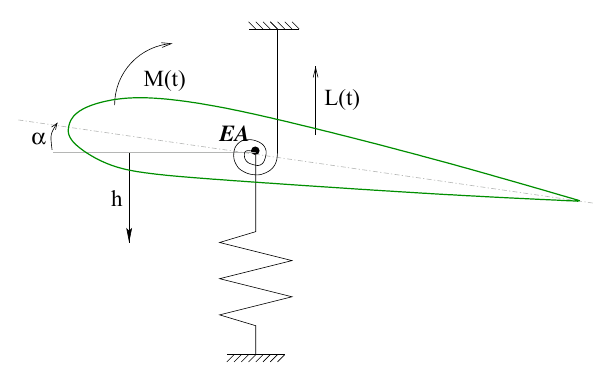
Fig. 1. Elastically supported airfoil with two degrees of freedom bending h and pitching α (on the left). Airfoil in undeformed position showing the elastic axis (EA) and center of gravity (CG) (on the right).